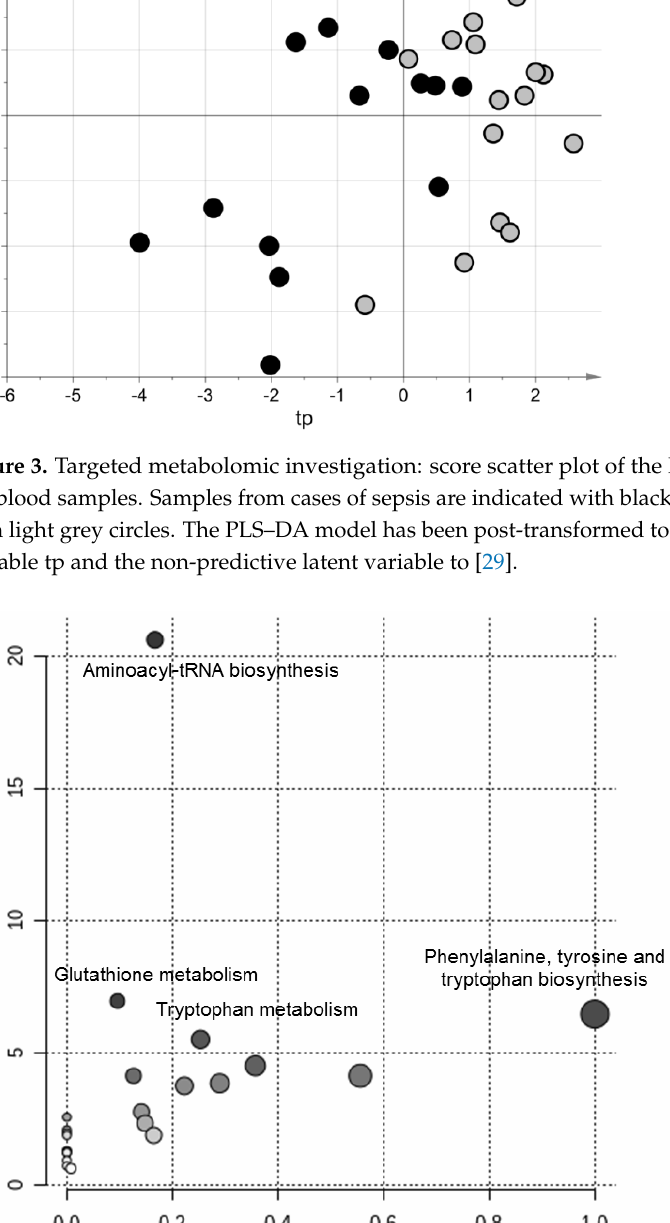
Figure 4. Targeted metabolomic investigation of the blood samples: over-representation pathway analysis. The impact of each perturbed pathway is shown against its negative log p -value (-log( p )). The names of the pathways with q -value of less than 0.10 are shown in the figure.